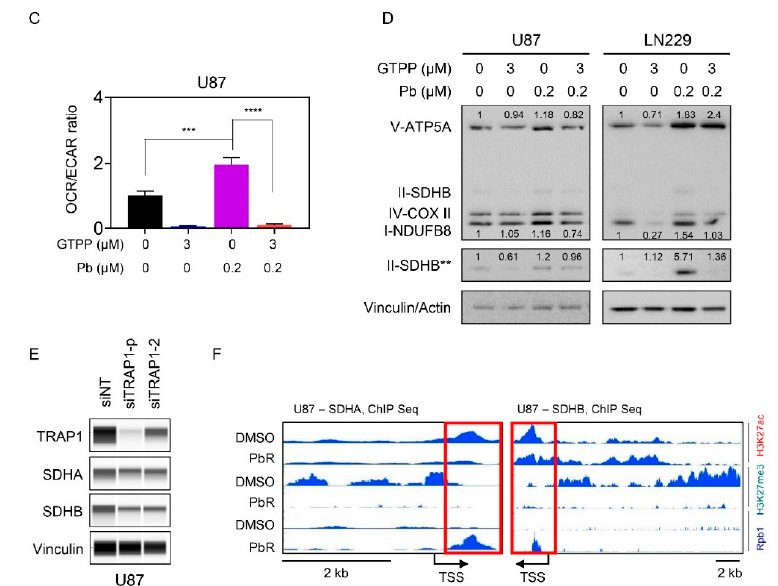
Figure 5. The combination treatment of gamitrinib and HDAC inhibitors interferes with GBM cell energy metabolism. ( A ) Mitochondrial stress test of U87 cells treated with gamitrinib, panobinostat or the combination of both for 24h. OM: oligomycin, FCCP: Carbonyl cyanide-4 (trifluoromethoxy) phenylhydrazone, R/A: rotenone and antimycin A ( n = 4); ( B ) The basal respiration and maximal respiration from experiment in (A) were calculated ( n = 3, 4); ( C ) Shown is the OCR/ECAR ratio from mitochondrial stress test of U87 cells treated with the indicated concentrations of gamitrinib, panobinostat or the combination of both for 24h ( n = 4). OCR: oxygen consumption rate, ECAR: extracellular acidification rate (a surrogate for glycolytic activity); ( D ) U87 and LN229 cells were treated with gamitrinib, panobinostat or the combination of both for 24h and the whole cell lysates were subjected to protein capillary electrophoresis. The double asterisk indicates a stronger exposure of SDHB. Vinculin is the loading control for U87 and actin is the loading control for LN229. The expression levels of V-ATP5A, I-NDUFB8 and II-SDHB were quantified by using ImageJ (shown in cursive font); ( E ) U87 cells were transfected with non-targeting (siNT) or TRAP1 specific siRNA (siTRAP1)(single or pool (p)) and the whole cell lysates were subjected to protein capillary electrophoresis; ( F ) Shown are the respective tracks of ChIP sequencing around SDHA and SDHB of parental and panobinostat treated U87 GBM cells. Highlighted is the transcriptional start site (TSS) by a red rectangle. Shown are means and SD. ANOVA was used for the statistical analysis. ***/**** p < 0.001.